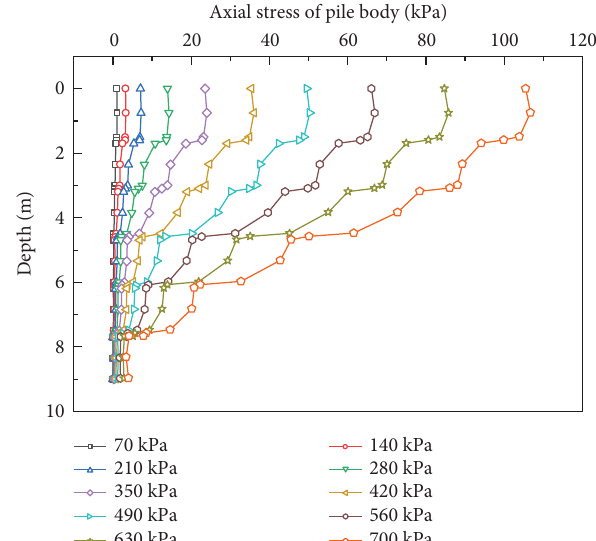
Figure 14: Pile axial force distribution